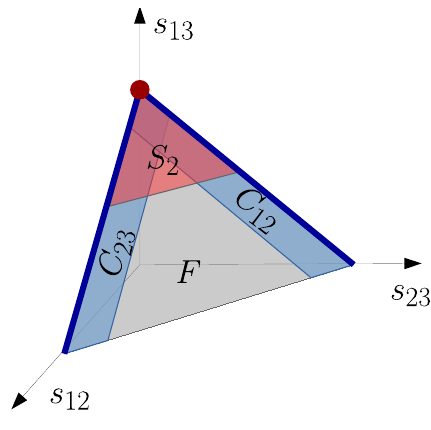
Figure 2 . The triangular surface Q 2 = s 12 + s 13 + s 23 is split into singular and (cid:12)nite regions. The red region is the soft region S 2 . Collinear regions C 12 and C 23 are indicated in blue. The (cid:12)nite region F is shown in grey. The soft-collinear overlap is just visible where the blue bands intersect with the red triangular